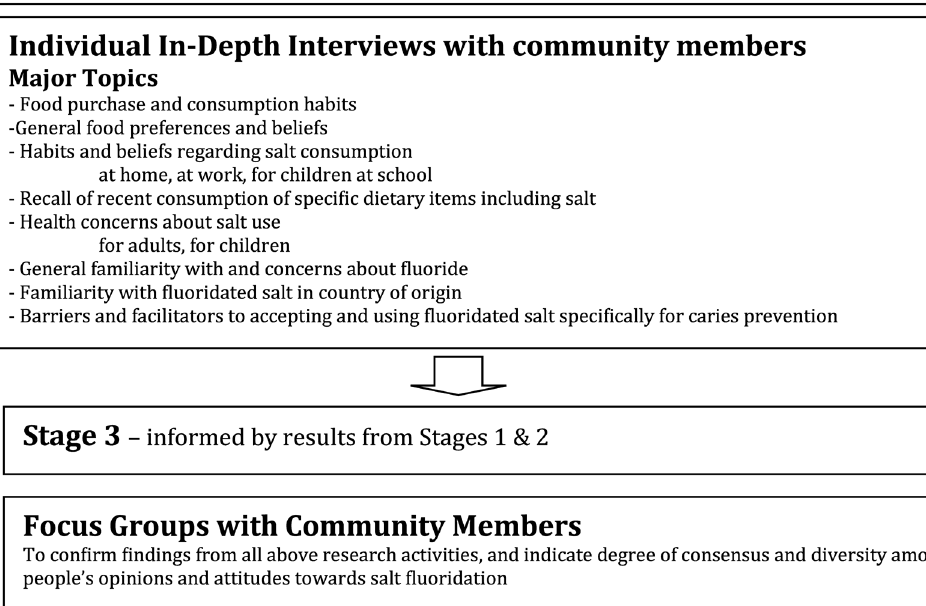
Fig 1. Flow chart showing connections between ethnographic